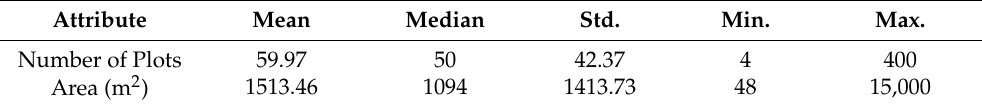
Table 3. Descriptive statistics for attributes of AGs ( n = 472) in